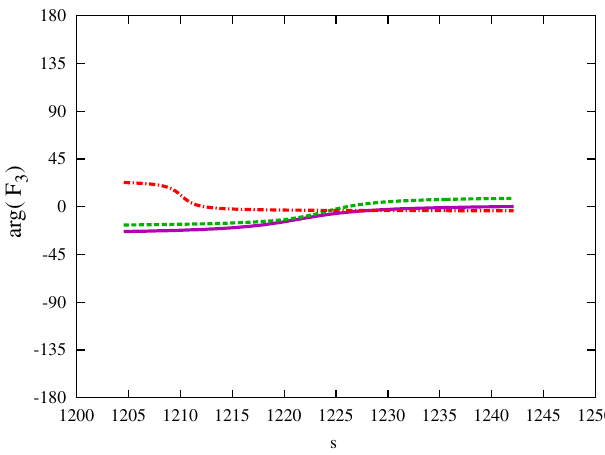
Þ at 250 GeV in the drift space FIG. 7. (Color) Graph of arg ð F 3 L232 of RHIC for three scenarios: (a) solid (purple)—no rota- tors; (b) dashed (green)—longitudinal polarization at both STAR and PHENIX; (c) dot-dashed (red)—no rotators at STAR, radial polarization at PHENIX. The horizontal axis shows the arclength in meters, measured from the 6 o’clock